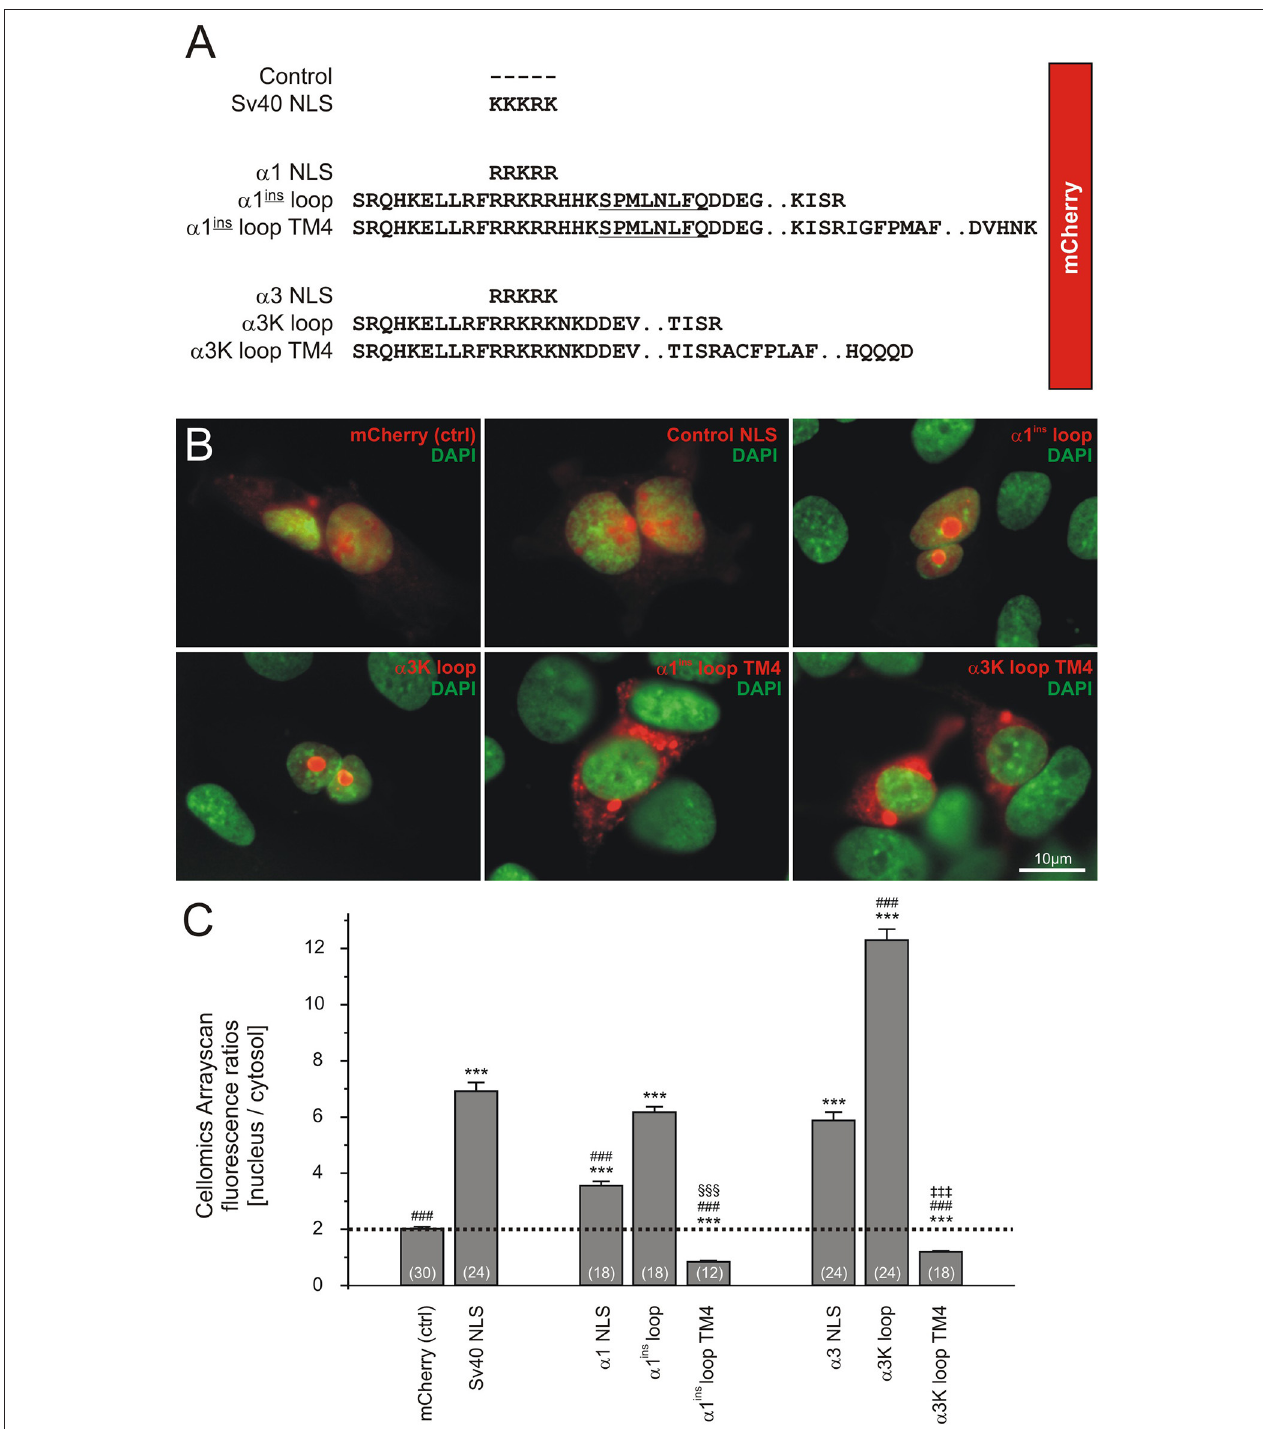
FIGURE 1 | The GlyR transmembrane domain 4 (TM4) determines cytosolic localization of the GlyR TM3-4 loop in HEK293T cells. (A) Design of molecular constructs. Upstream of mCherry, different sequences were cloned including SV40 NLS (KKKRK), GlyR α 1 loop NLS (RRKRR), and GlyR α 1 ins TM3-4 without or with the TM4. The respective constructs were also established for the GlyR α 3 subunit. (B) Representative images showing fluorescence signals of mCherry constructs (red) and DAPI (green). (C) Quantification of the fluorescence ratios (nucleus/cytosol) of mCherry signals using Cellomics plate reader software in live cells stained with Hoechst 33342. Note that the most pronounced difference between nucleus/cytosol ratios of GlyR TM3-4 constructs with or without the TM4 domain was observed for the GlyR α 3 subunit. Significance levels are given for conditions compared to control (*), compared to SV40-NLS (#), compared to α 1 ins loop (§) and compared to α 3K loop (‡). In all cases, three symbols mark statistical significance ( P < 0.001), as assessed using Mann-Whitney test. At least 1,000 cells per condition and cell culture plate well were analyzed. The number of wells analyzed in 3 independent experiments is indicated in brackets (see Table 1 ).